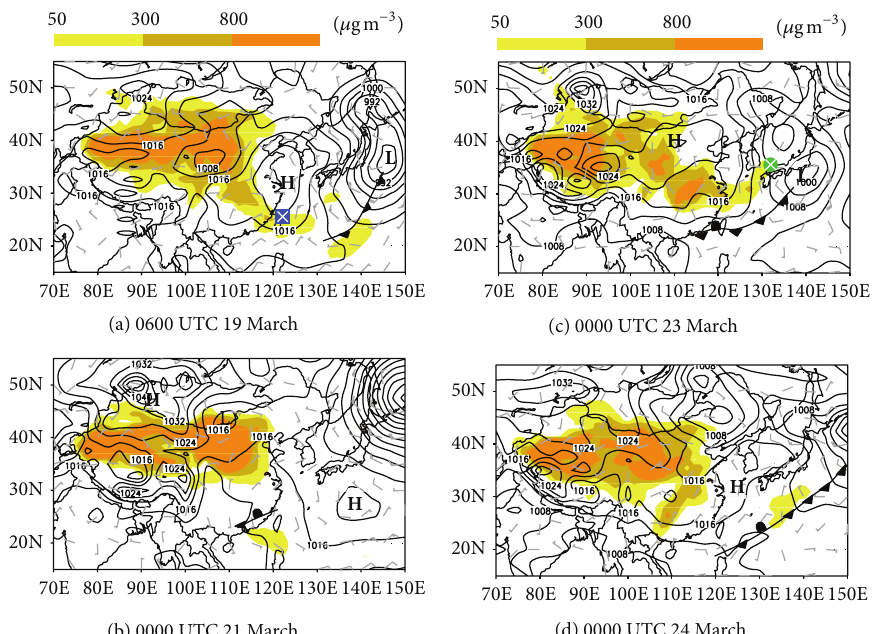
Figure 8: Surface maps and simulated dust distributions for the southeastward event at (a) 0600 UTC on 19 March and (b) 0000 UTC on 21 March and eastward event at (c) 0000 UTC on 23 March and (d) 0000 UTC on 24 March. Sea-level pressure is analyzed at 4 hPa interval. The full and half barbs represent 10 and 5m s −1 , respectively. The traced dust parcels predicted by the trajectory model are marked (circle or square with